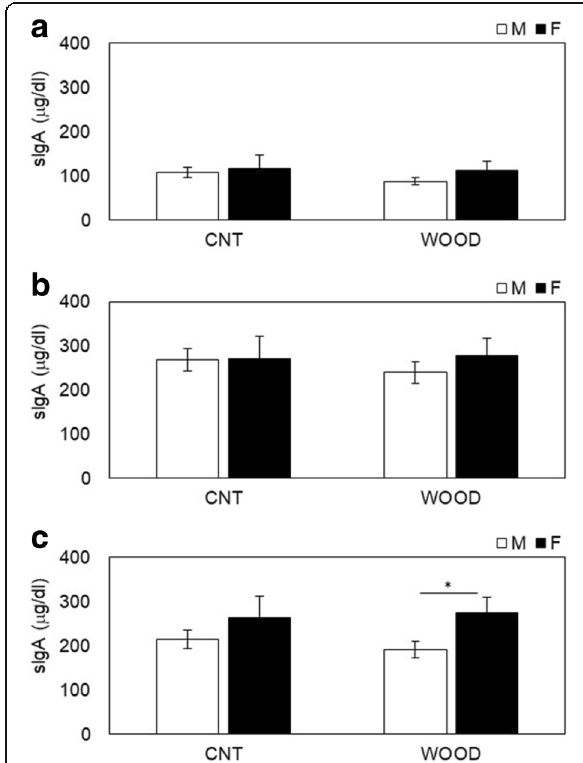
Fig. 6 Variation of salivary sIgA levels changes at a pre-, b during, and c post-experiment measurements. The bar in a – c show the changes in the salivary cortisol levels of participants in the control condition (left) and Japanese cedar wood panels (experimental; light) conditions: male participants (white) and female participants (black).CNT indicates the control condition, while WOOD indicates the experimental condition. The bars in a show that the differences between conditions were not significant. The bars in b show that the differences between conditions were not significant. The bars in c show that the difference in values between male and female participants was significant ( p = 0.029) in the Japanese cedar wood panels condition. *statistical significance ( p < 0.05). Data are shown as mean ±